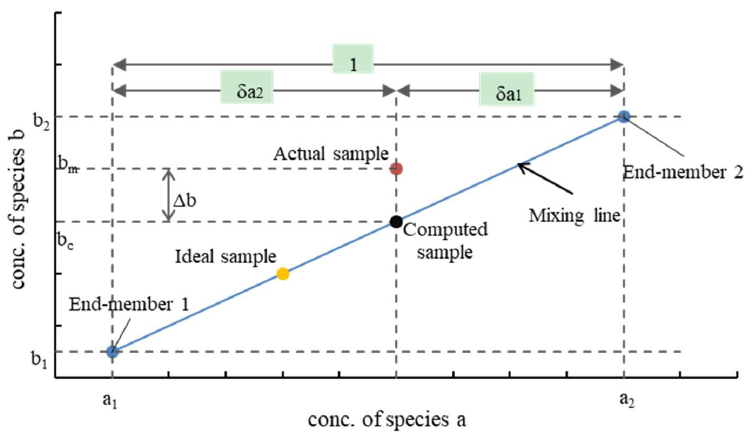
Figure 3. The schematic diagram of the binary mixing model. ( x -axis: concentration of species a , y -axis: concentration of species b ).